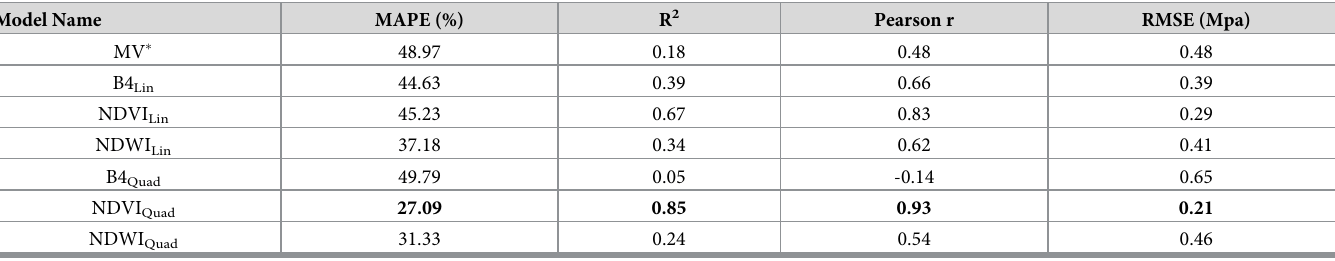
C w and the predicted C w by OLI sensor (R 2 = 0.84, Pearson r = 0.92) was observed. These Table 3. Statistical results obtained through the LOOCV.